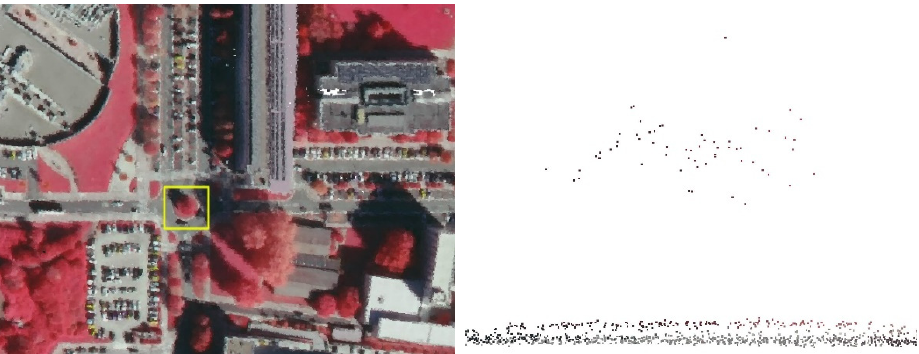
Figure 12. Isolated vegetation element. 2017 LiDAR cloud, density: 2.2 points/m 2 . UPV/EHU campus in DSS.